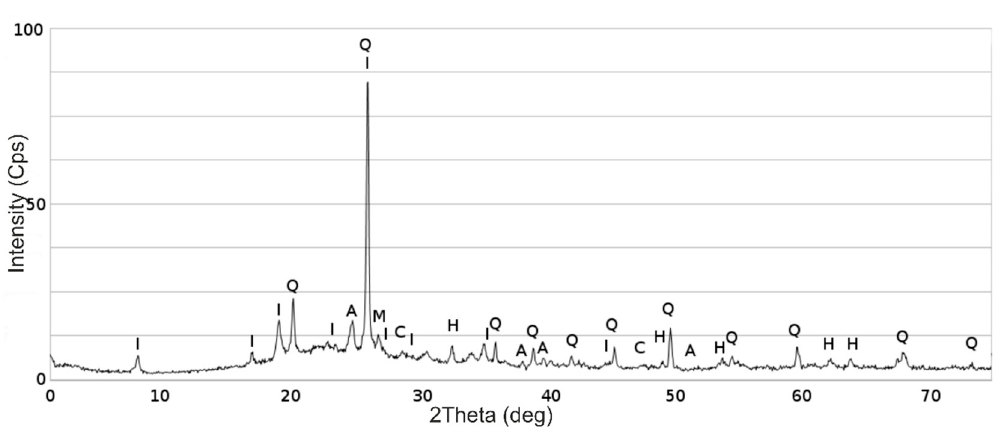
Figure 12. X-ray diffraction pattern of bottom ash from the combustion of gasification residue resulting from the gasification of coal from the Janina deposit, Q—quartz, I—illite, H—hematite, M—microcline, A—anhydrite, C—calcite.